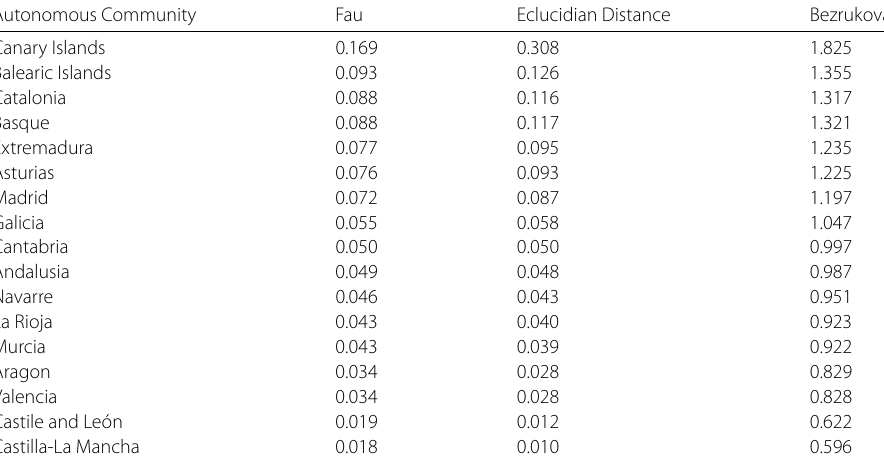
Table 4 Faultline strength (Fau), distance and Bezrukova measurement for Spanish CCAAs Autonomous